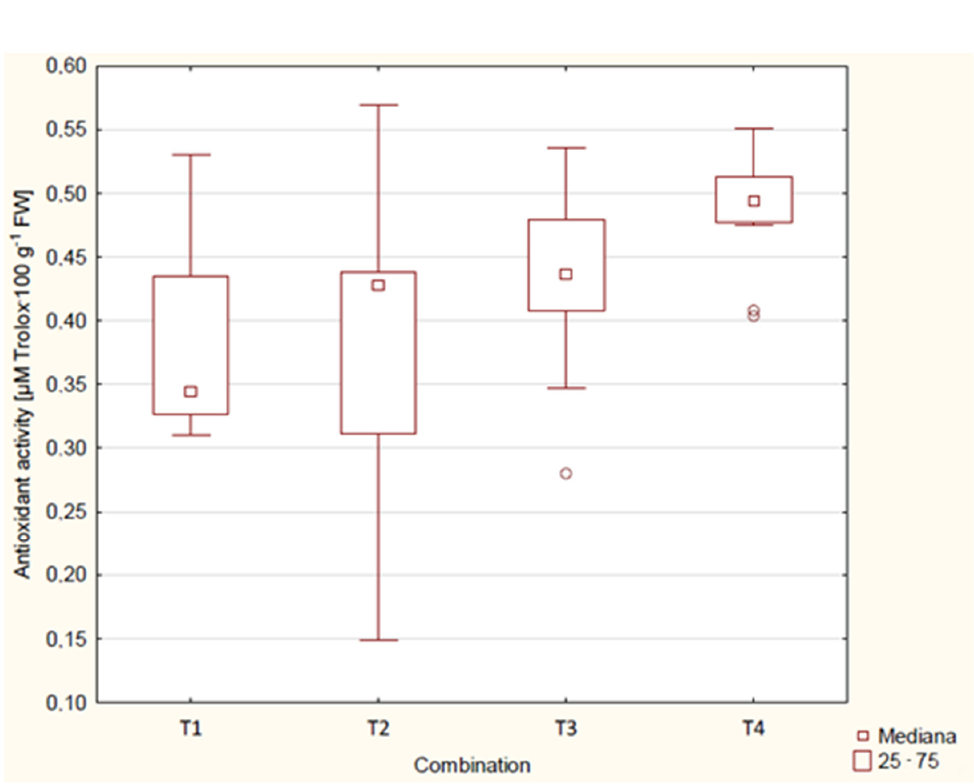
Figure 1. Influence of fertilization technology on antioxidant activity—average per harvest year, and three year average.